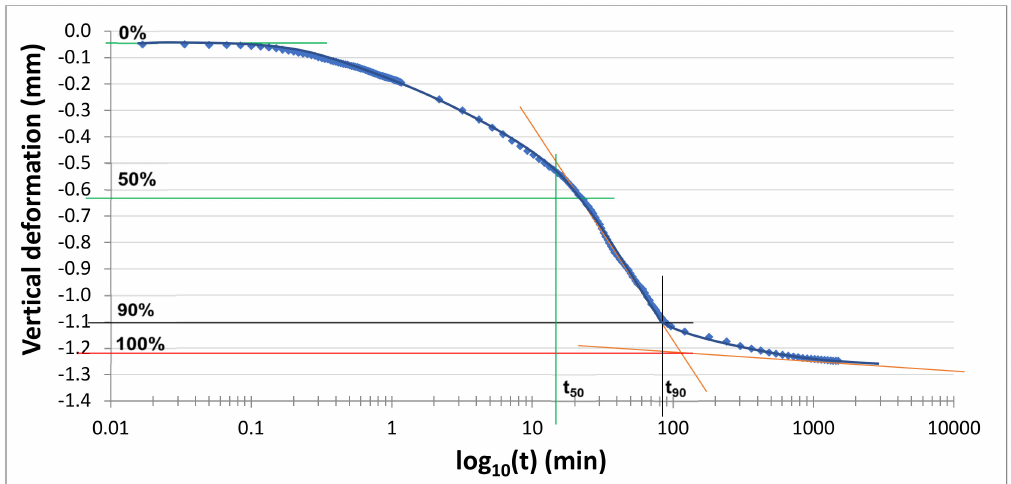
Figure 8. Consolidation curve of loading step 9 (high content muscovite soil).